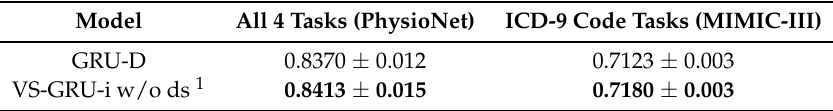
Table 8. Comparison on deep supervision in